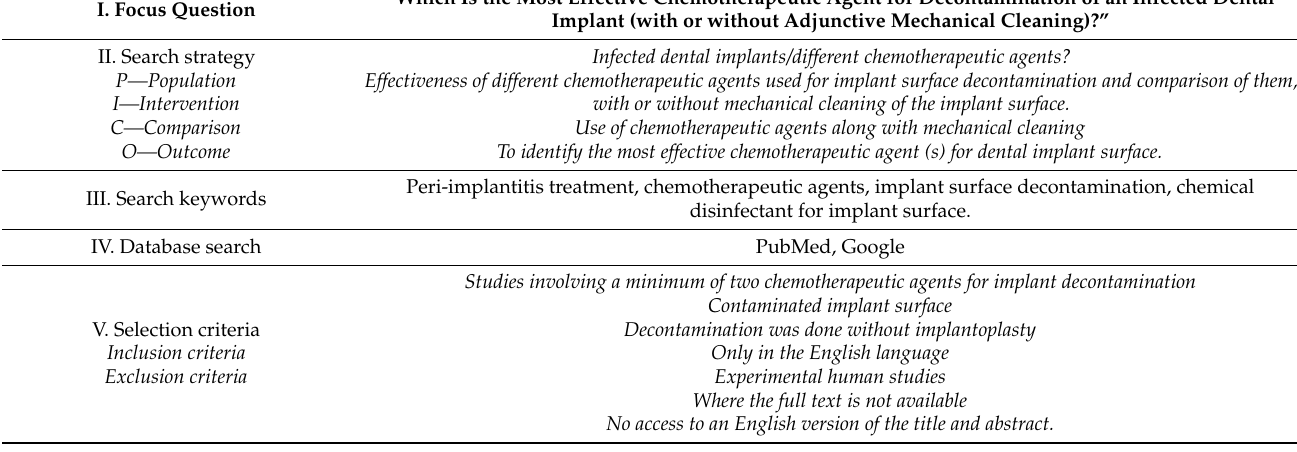
Table 1. Systematic search